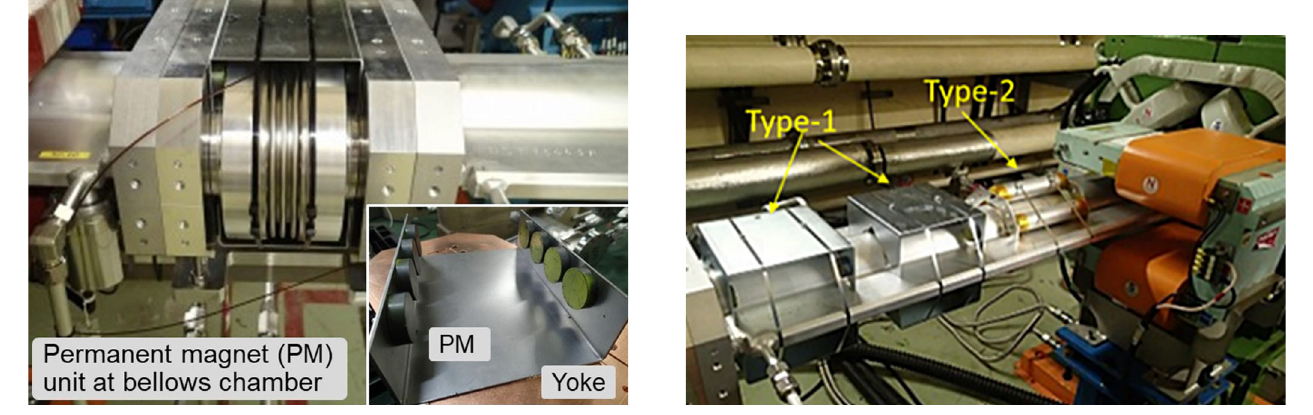
FIG. 5. PM units attached to an Al-alloy bellows chamber. FIG. 6. Type-1 and type-2 units at drift